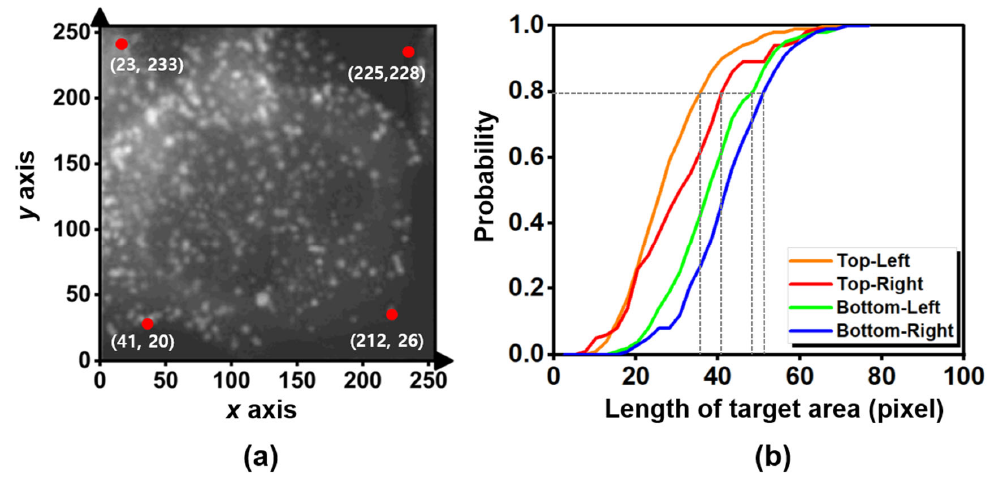
Figure 3. Statistical results of the two additives: ( a ) represents the averaged positions (red dots) of the alphabet characters and scale bars regarding the example of the microscopic images (reprinted with permission from Ref. [12]. Copyright (2020) Elsevier) and ( b ) represents the cumulative probability distribution function, according to the length of the target area (pixel) of the target regions comprising the additives.